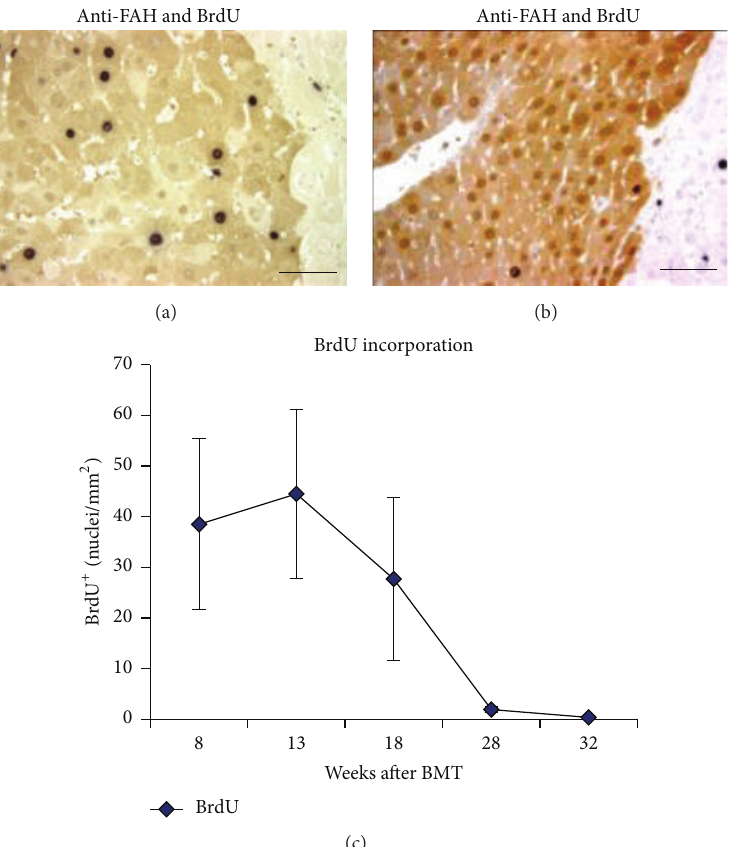
Figure 2: Kinetics of cell proliferation in regenerating nodules double stained for BrdU/FAH by immunohistochemistry. BrdU uptake was detected by an anti-BrdU antibodies staining in regenerating nodules at 13 weeks (a) and 32 weeks (b) after BMT, (c) the number of BrdU + hepatocytes per mm 2 of the FAH + regenerating nodule surface area ( 𝑛 ≥ 5 ). Means ± SD are shown. Scale bar represents 60 𝜇